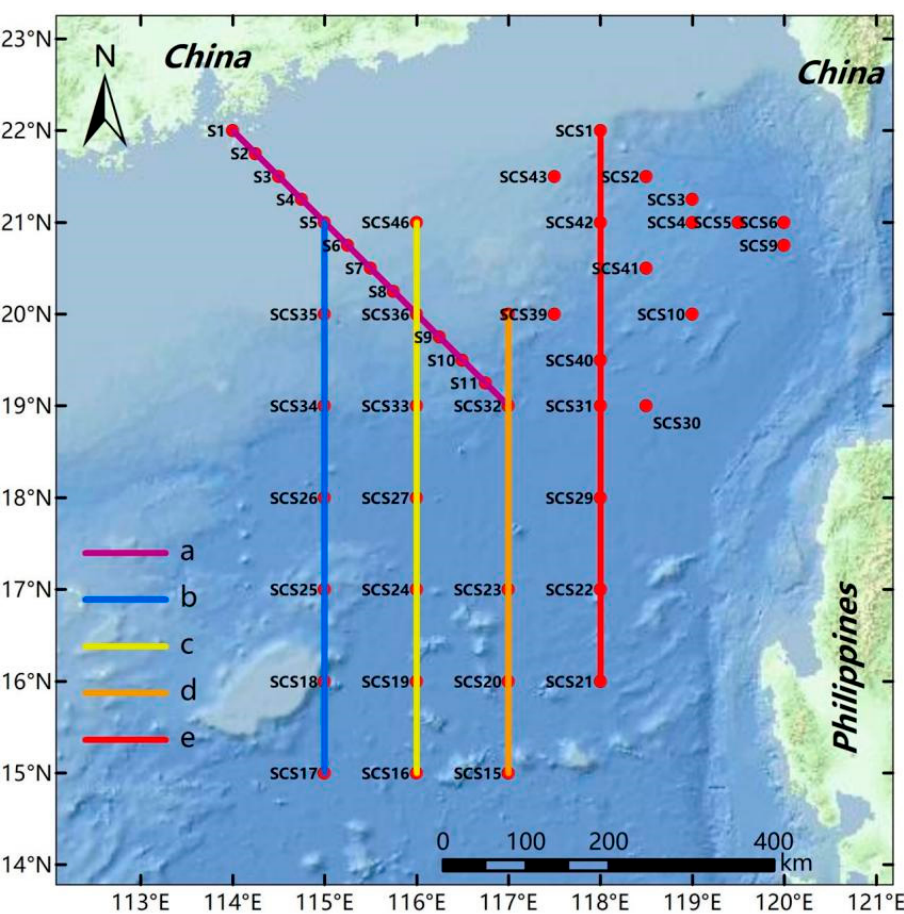
Figure 1. Locations of the sampling stations in the northern South China Sea.